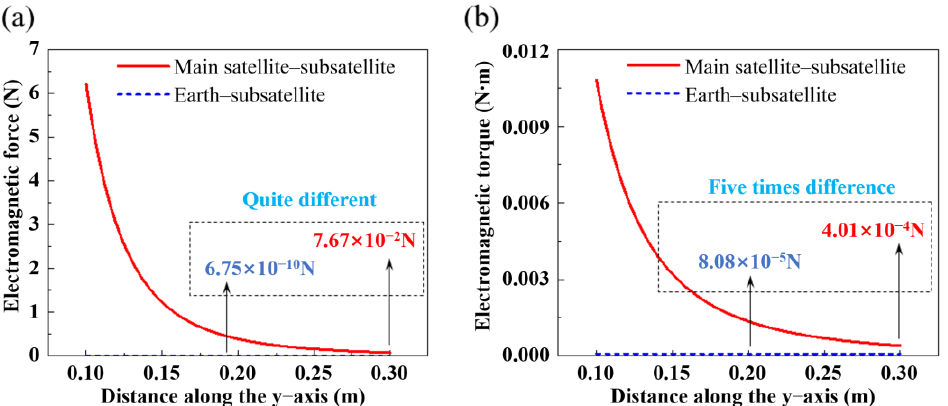
Figure 4. The electromagnetic force ( a ) and torque ( b ) of the main satellite–subsatellite, and the Earth–subsatellite.